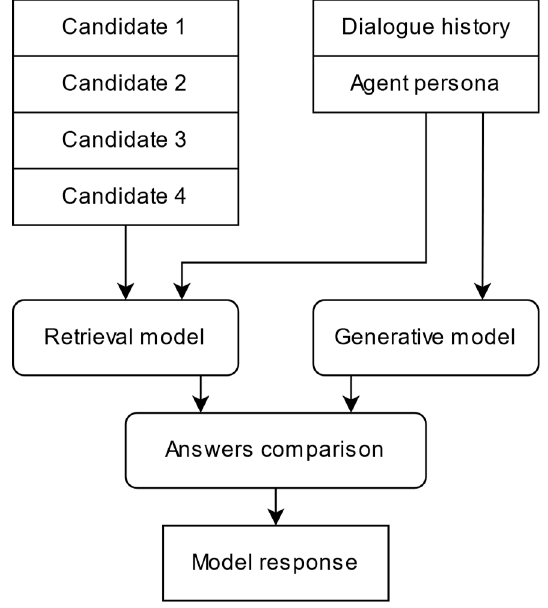
Figure 2. Retrieve and Refine hybrid